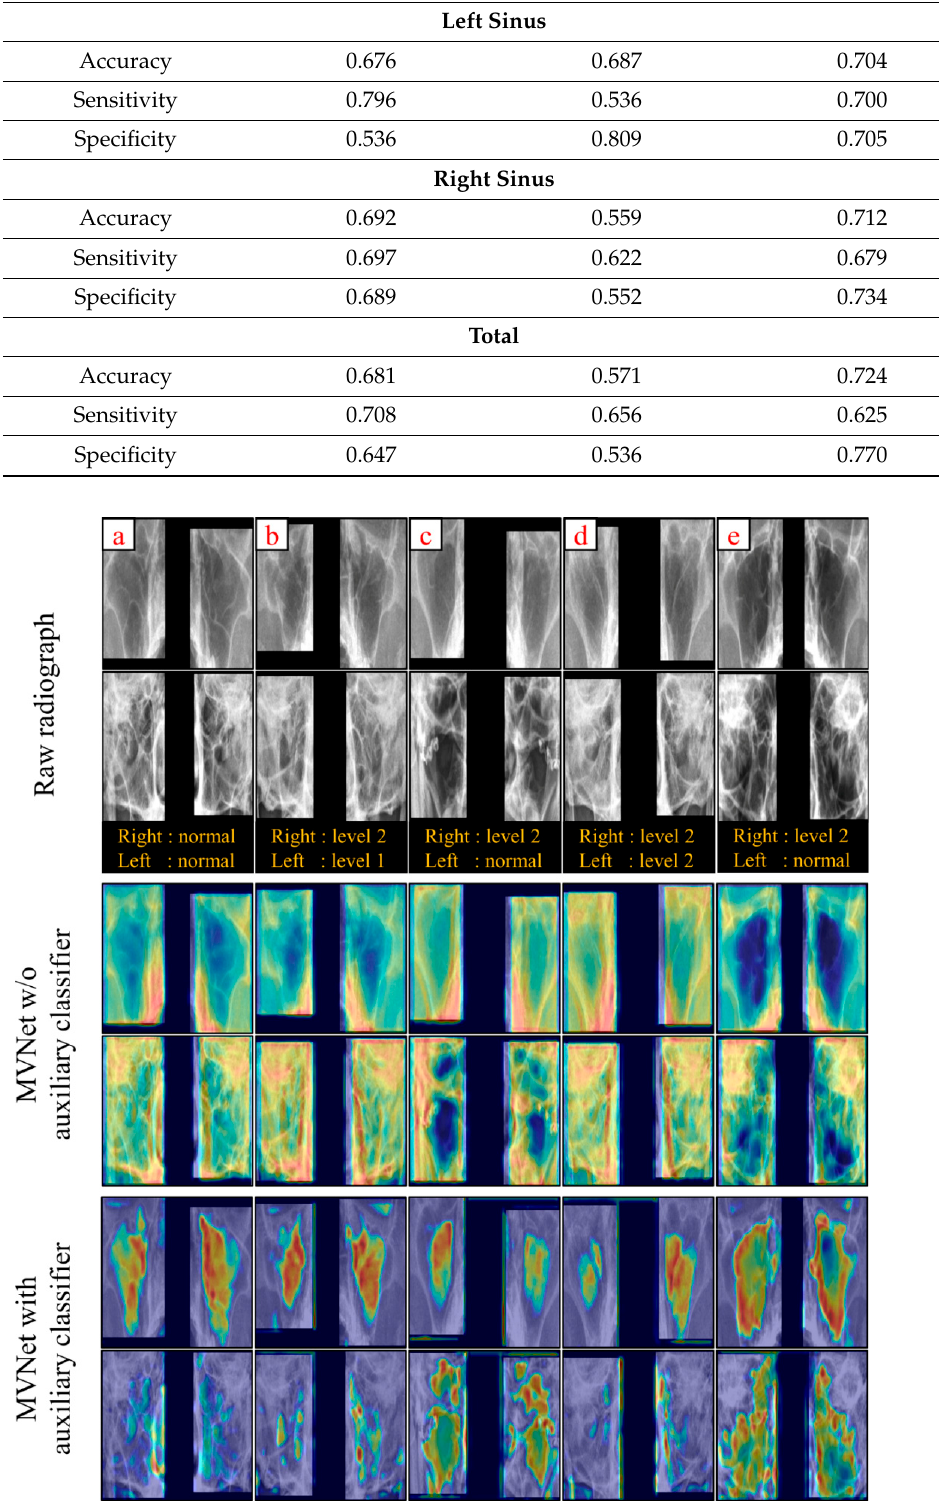
Figure 5. Grad ‐ CAM analysis from the images of 5 subjects in the 3rd convolution block of MVNet and Aux ‐ MVNet ( a – e ). The Gold ‐ standard of sinusitis levels were presented below the raw images. Odd rows represent Waters’ view, and even rows represent Caldwell’s